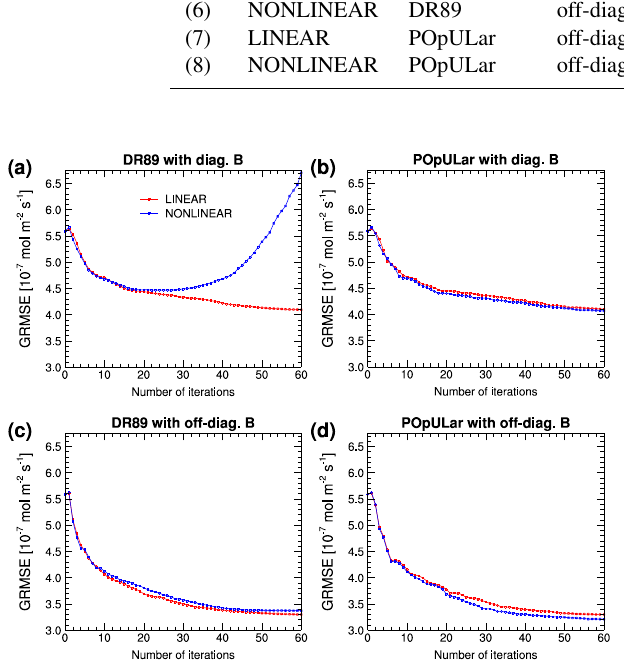
Figure 4. The same as Fig. 3 but for GRMSE changes with itera-